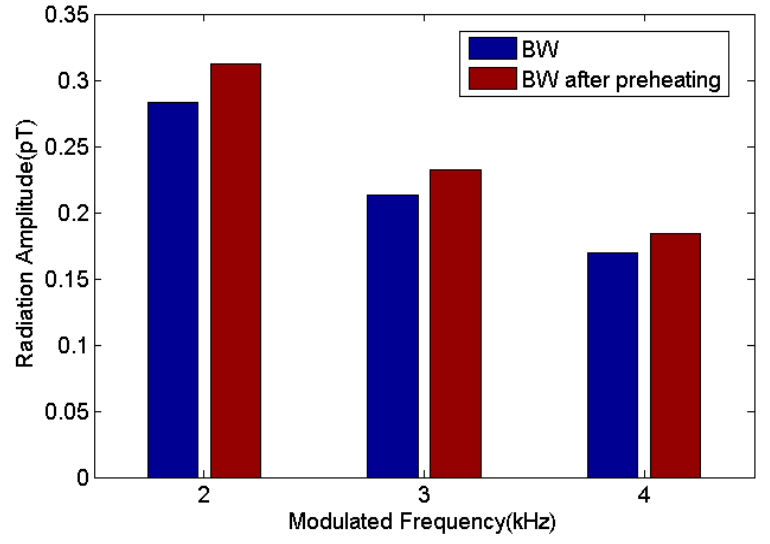
Figure 8. Simulation of signal amplitude of ELF/VLF waves generated by BW in D region with and without preheating at different modulated frequencies received at Chistochina (62.62°N, − 144.62°W, 37 km from HAARP).